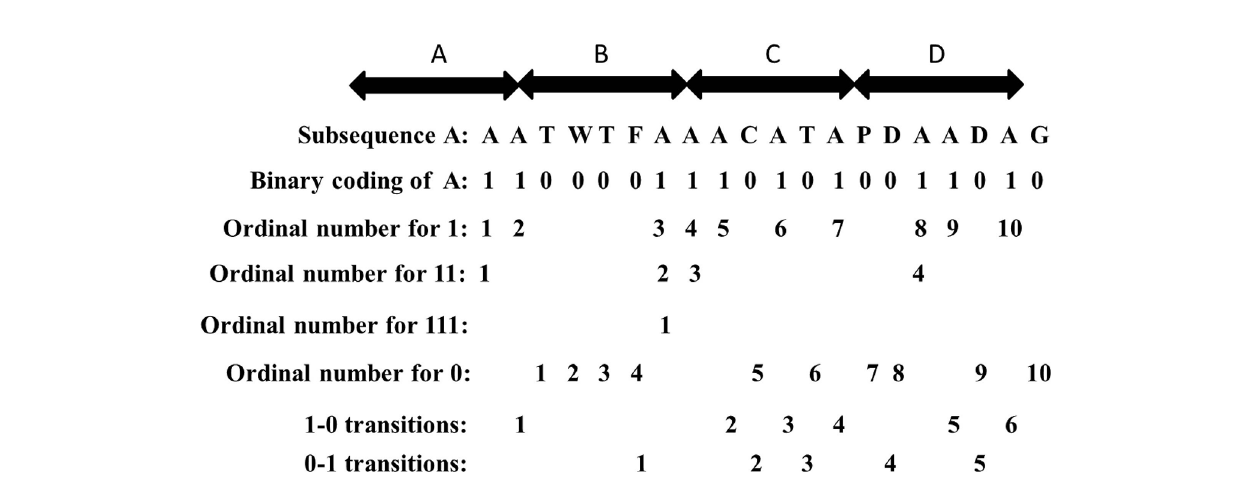
FIGURE 2 | The composition and transition of subsequence “ AATWTFAAACATAPDAADAG ” with respect to amino acid